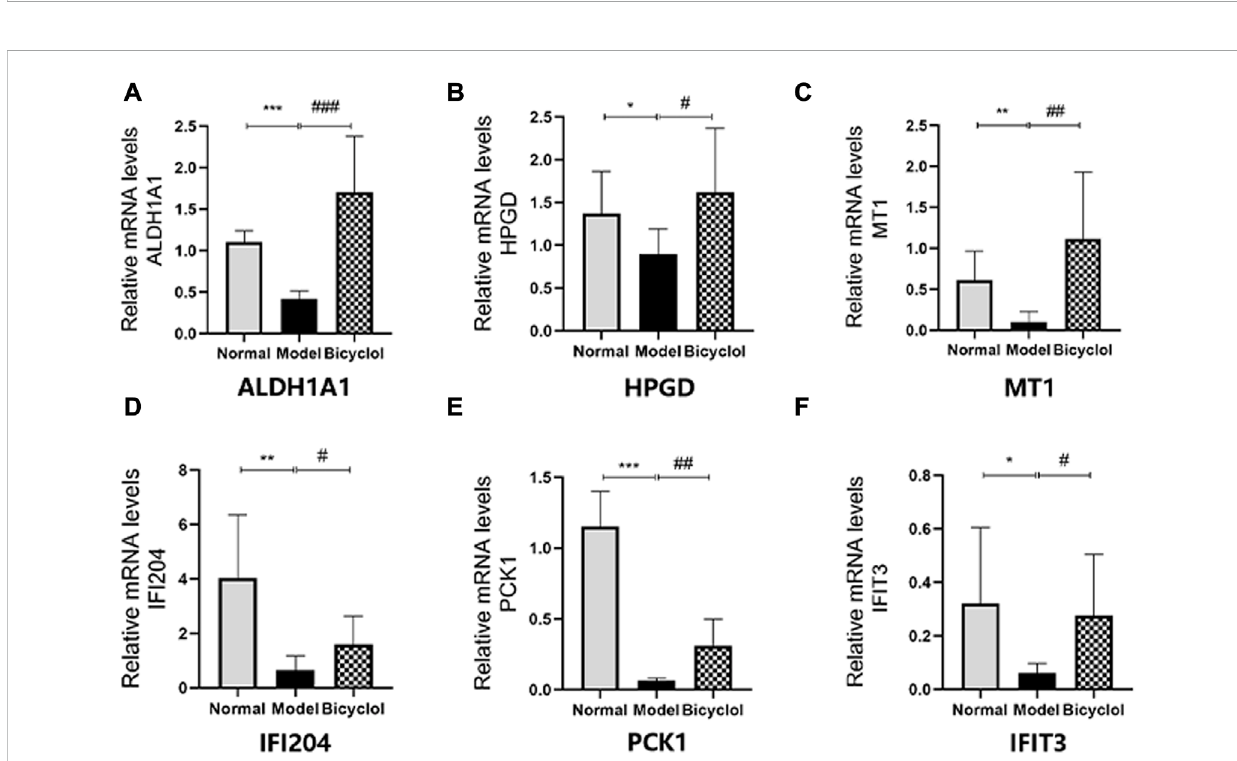
Expression ofthegenesinvolvedinbiologicalprocesses.RelativemRNAlevelsof (A) ALDH1A1(n=8), (B) HPGD(n=6), (C) MT1(n=7), (D) IFI204(n=8), (E) PCK1 (n=6), (F) IFIT3 (n=8). * p < 0.05 vs Normal, ** p < 0.01 vs Normal, ***p < 0.001 vs Normal, # p < 0.05 vs Model, ## p < 0.01 vs Model, ### p < 0.001 vs